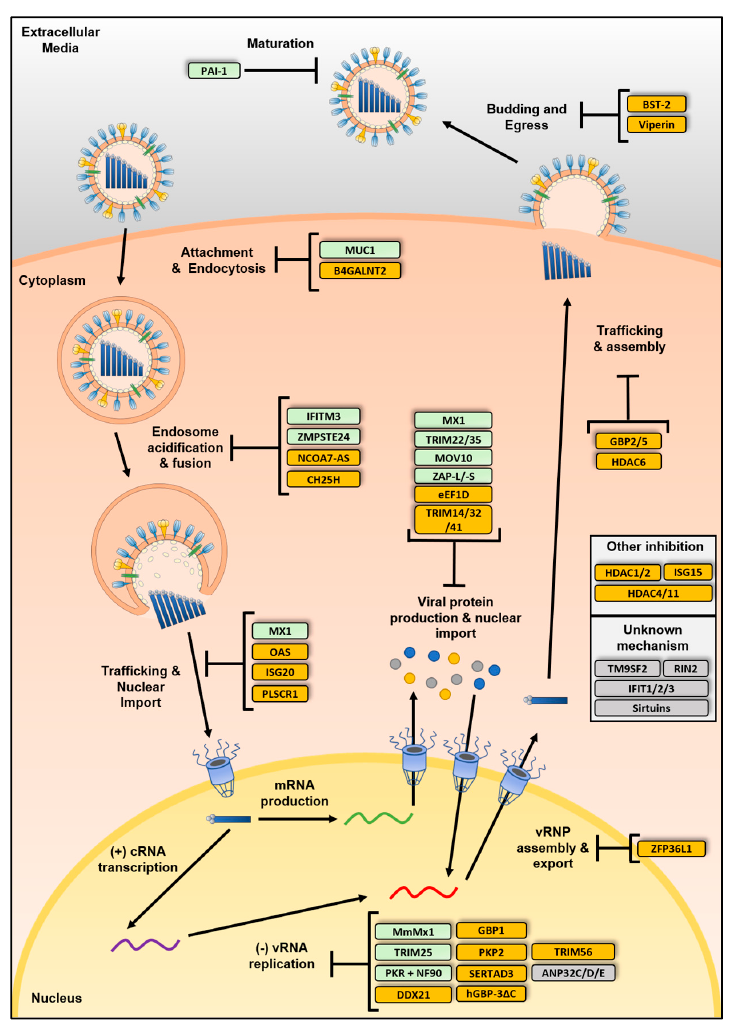
Figure 3. Schematic representation of IAV life cycle with the host cell restriction factors that target each step. Factors highlighted in green are those that are generally accepted or that have consequent data backing them, in orange factors that need further investigation to confirm their role as IAV restriction factors for instance in vivo (e.g., NCOA7-AS) and in grey, those for which very little data is